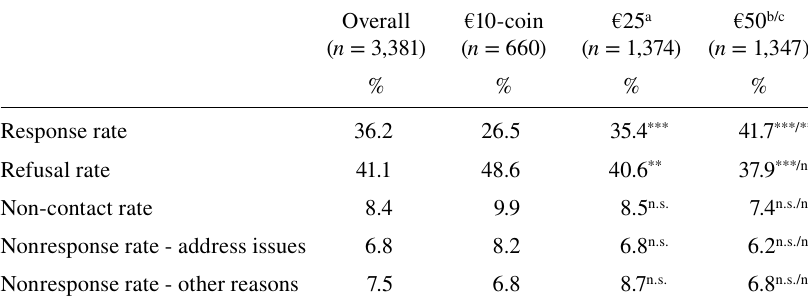
Response and nonresponse rates by incentive treatment